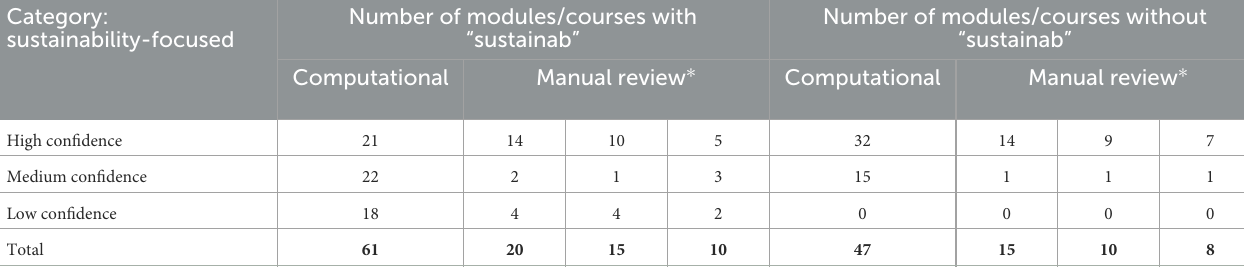
TABLE 3 Classifications of modules/courses with and without the RK “sustainab”. Category: Number of modules/courses with sustainability-focused “sustainab” Computational Manual review ∗ Computational Manual review ∗